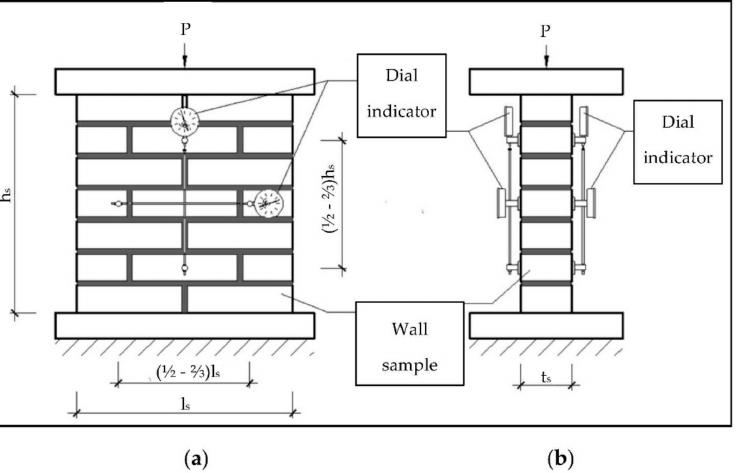
Figure 3. Compressive strength test in the direction perpendicular to the horizontal mortar joints of the wall samples: ( a ) front view and ( b ) side view.